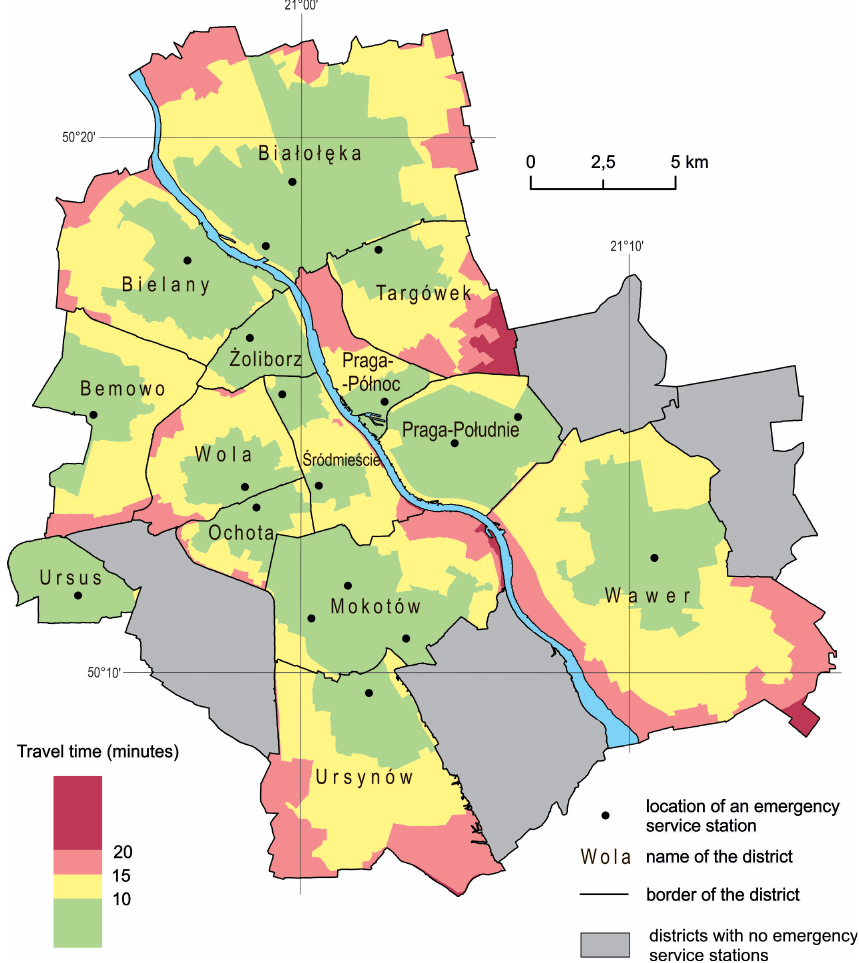
Fig. 2. Travel time (in minutes) in Warsaw districts (own